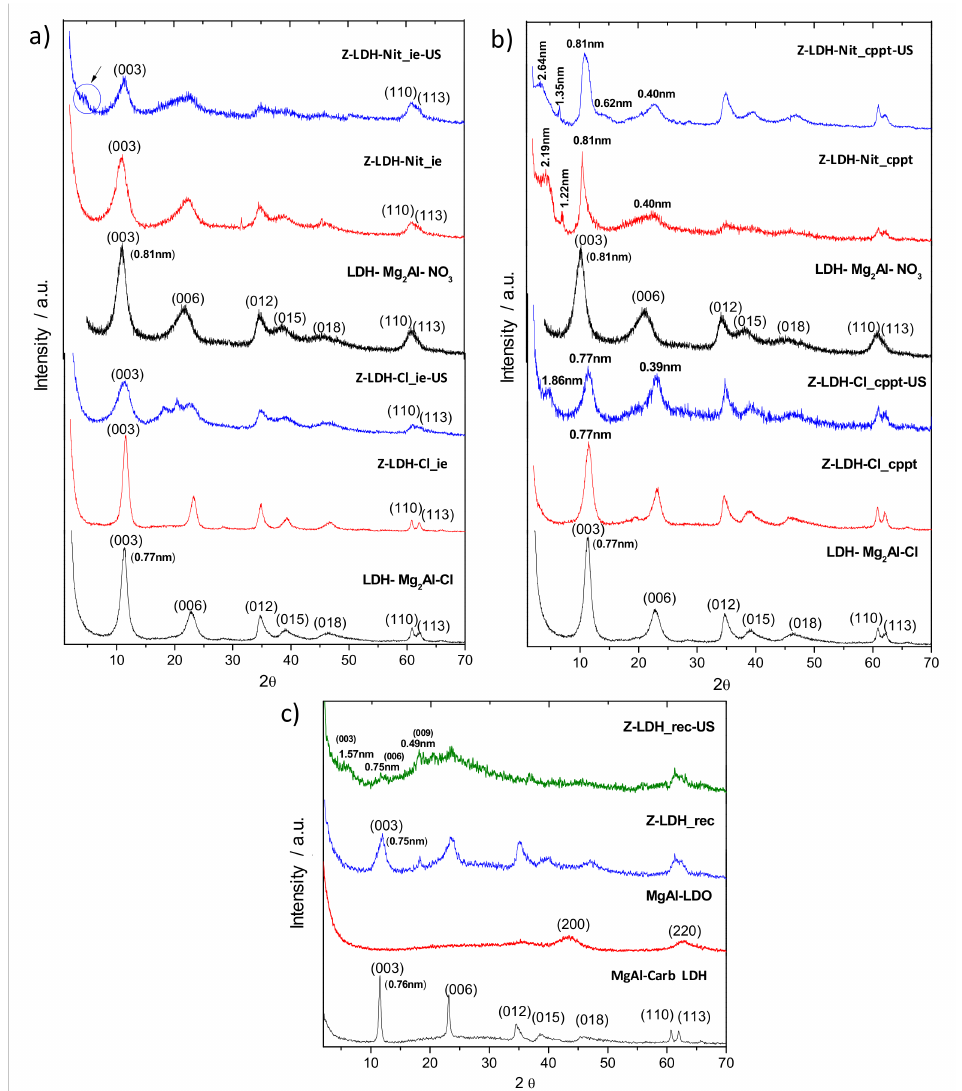
Figure 4. XRD di ff ractograms of Z-LDH biohybrids prepared by the ( a ) ion-exchange, ( b ) co-precipitation, and ( c ) reconstruction methods from zein dissolved in 0.1 M NaOH with and without US (60